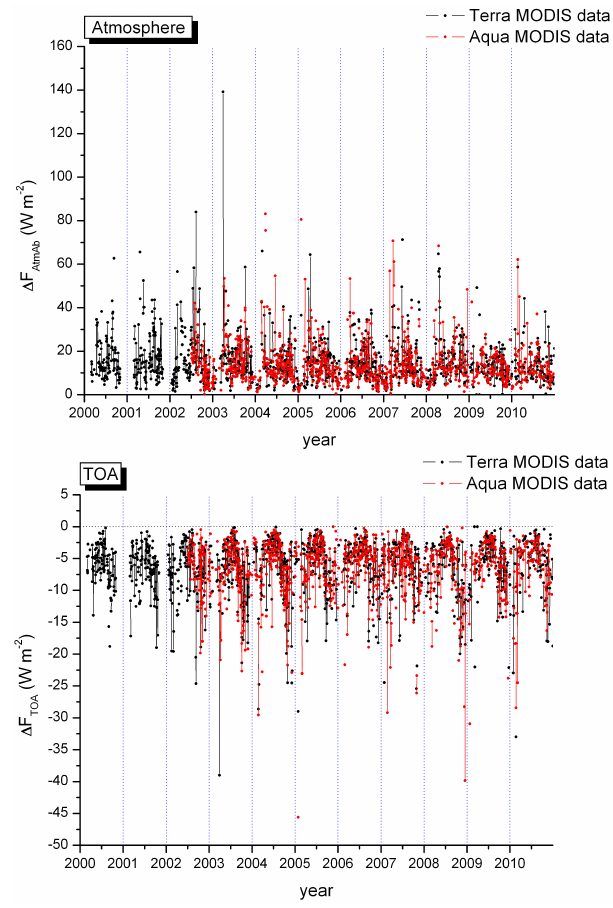
Fig. 8. Time series of the instantaneous aerosol effect in the atmo- sphere (a) and at TOA (b) , as computed from the model, based on MODIS Level 2 Terra and Aqua data, for the period 2000–2010, at the HCMR station, Crete. Table 2. Mean instantaneous values with standard deviations of DRE for the period 2000–2010, calculated from both output data sets (Aqua and Terra